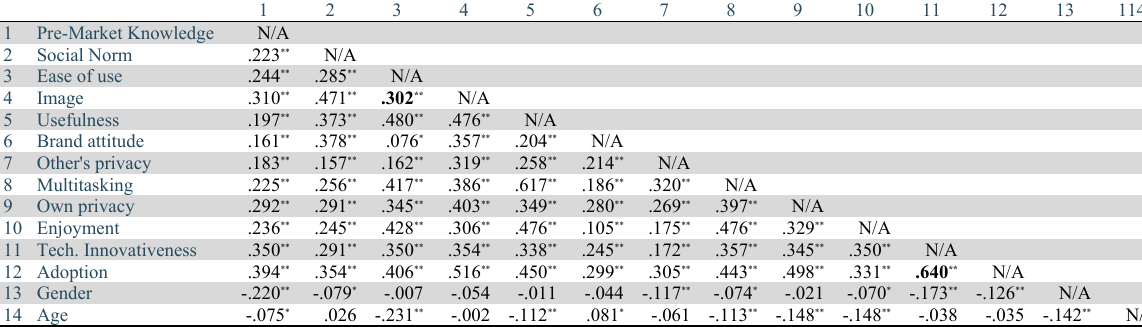
Inter-Item Correlation